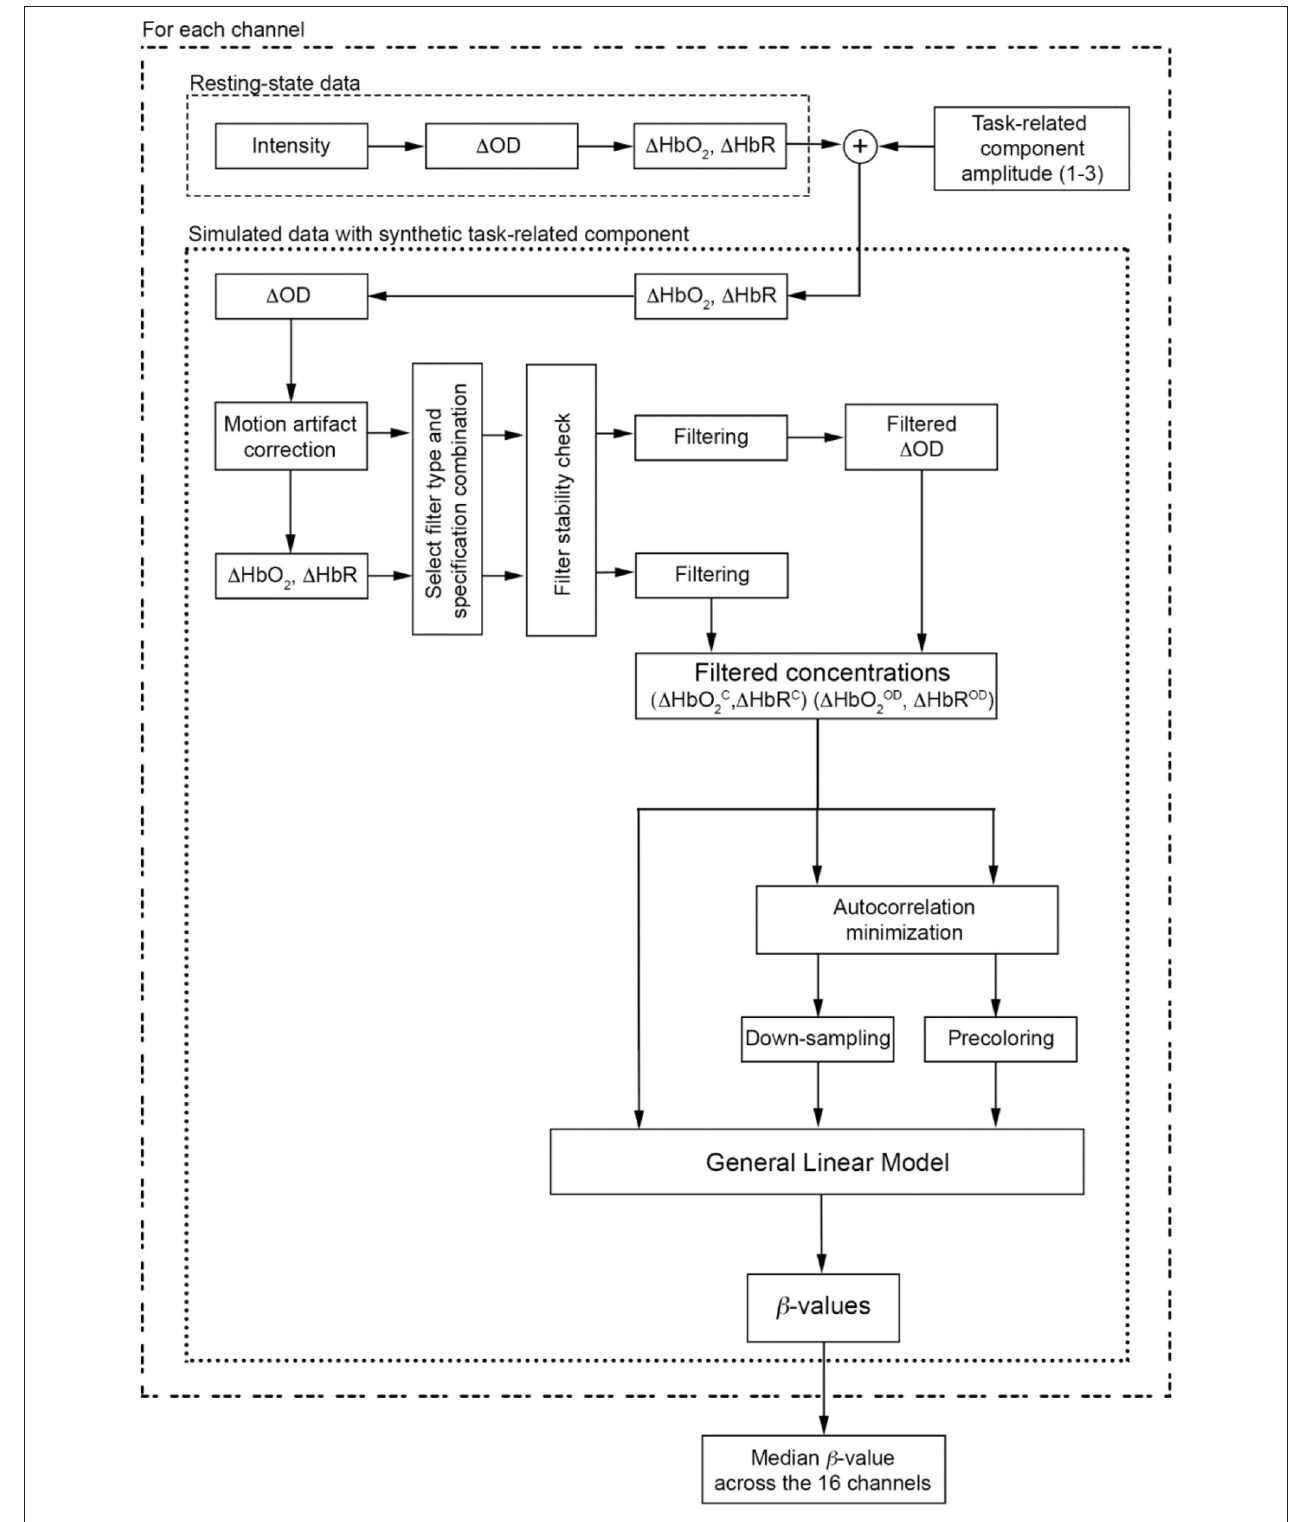
FIGURE 4 | Data analysis flow chart applied to each participant and to each task-related component amplitude. The procedure is also applied for each filter type and specification combinations.